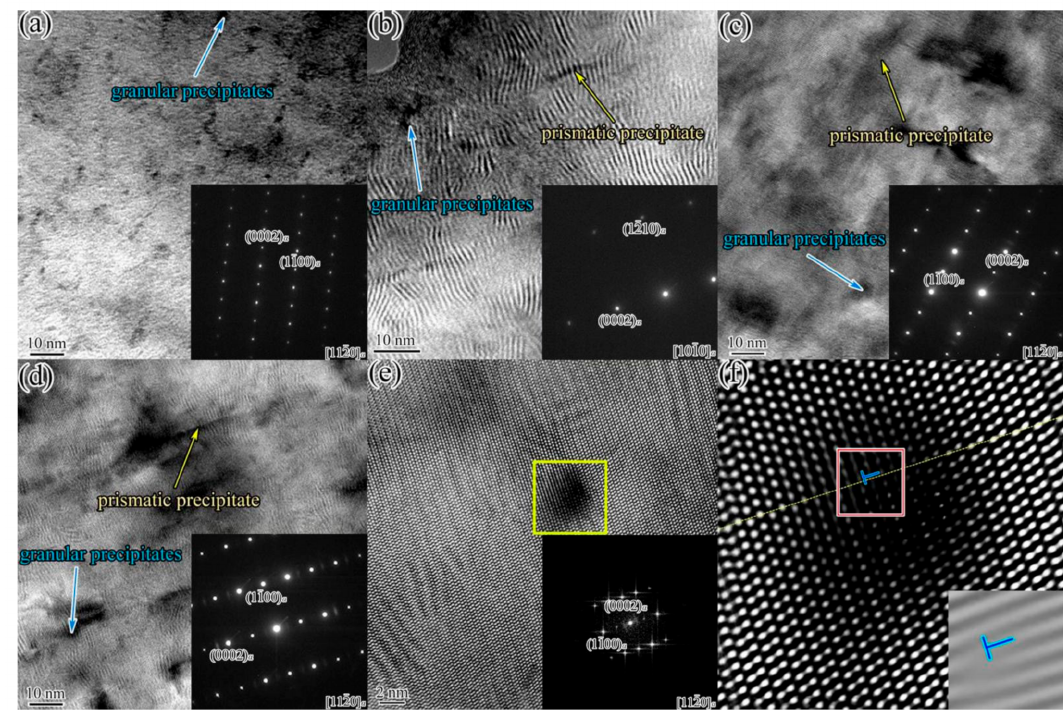
Figure 5. TEM micrographs and SAED patterns of the IEECAPed and subsequently aged Mg-xNd-2.0Sm-0.4Zn-0.4Zr alloys with different Nd content (wt.%): ( a ) 0.5, ( b ) 1.0, ( c ) 1.5, ( d ) 2.0. ( e ) HRTEM images of the granular precipitates in Mg-2.0Nd-2.0Sm-0.4Zn-0.4Zr along [1120] α zone axis; ( f ) IFFT image and the lattice fringes obtained by IFFT of the selected area from ( e ).